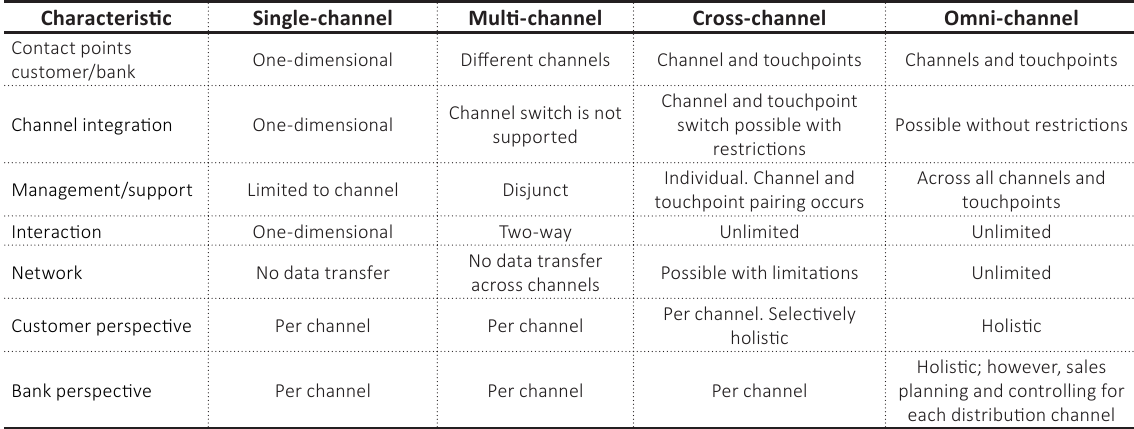
Table 1. Description of the different distribution channel